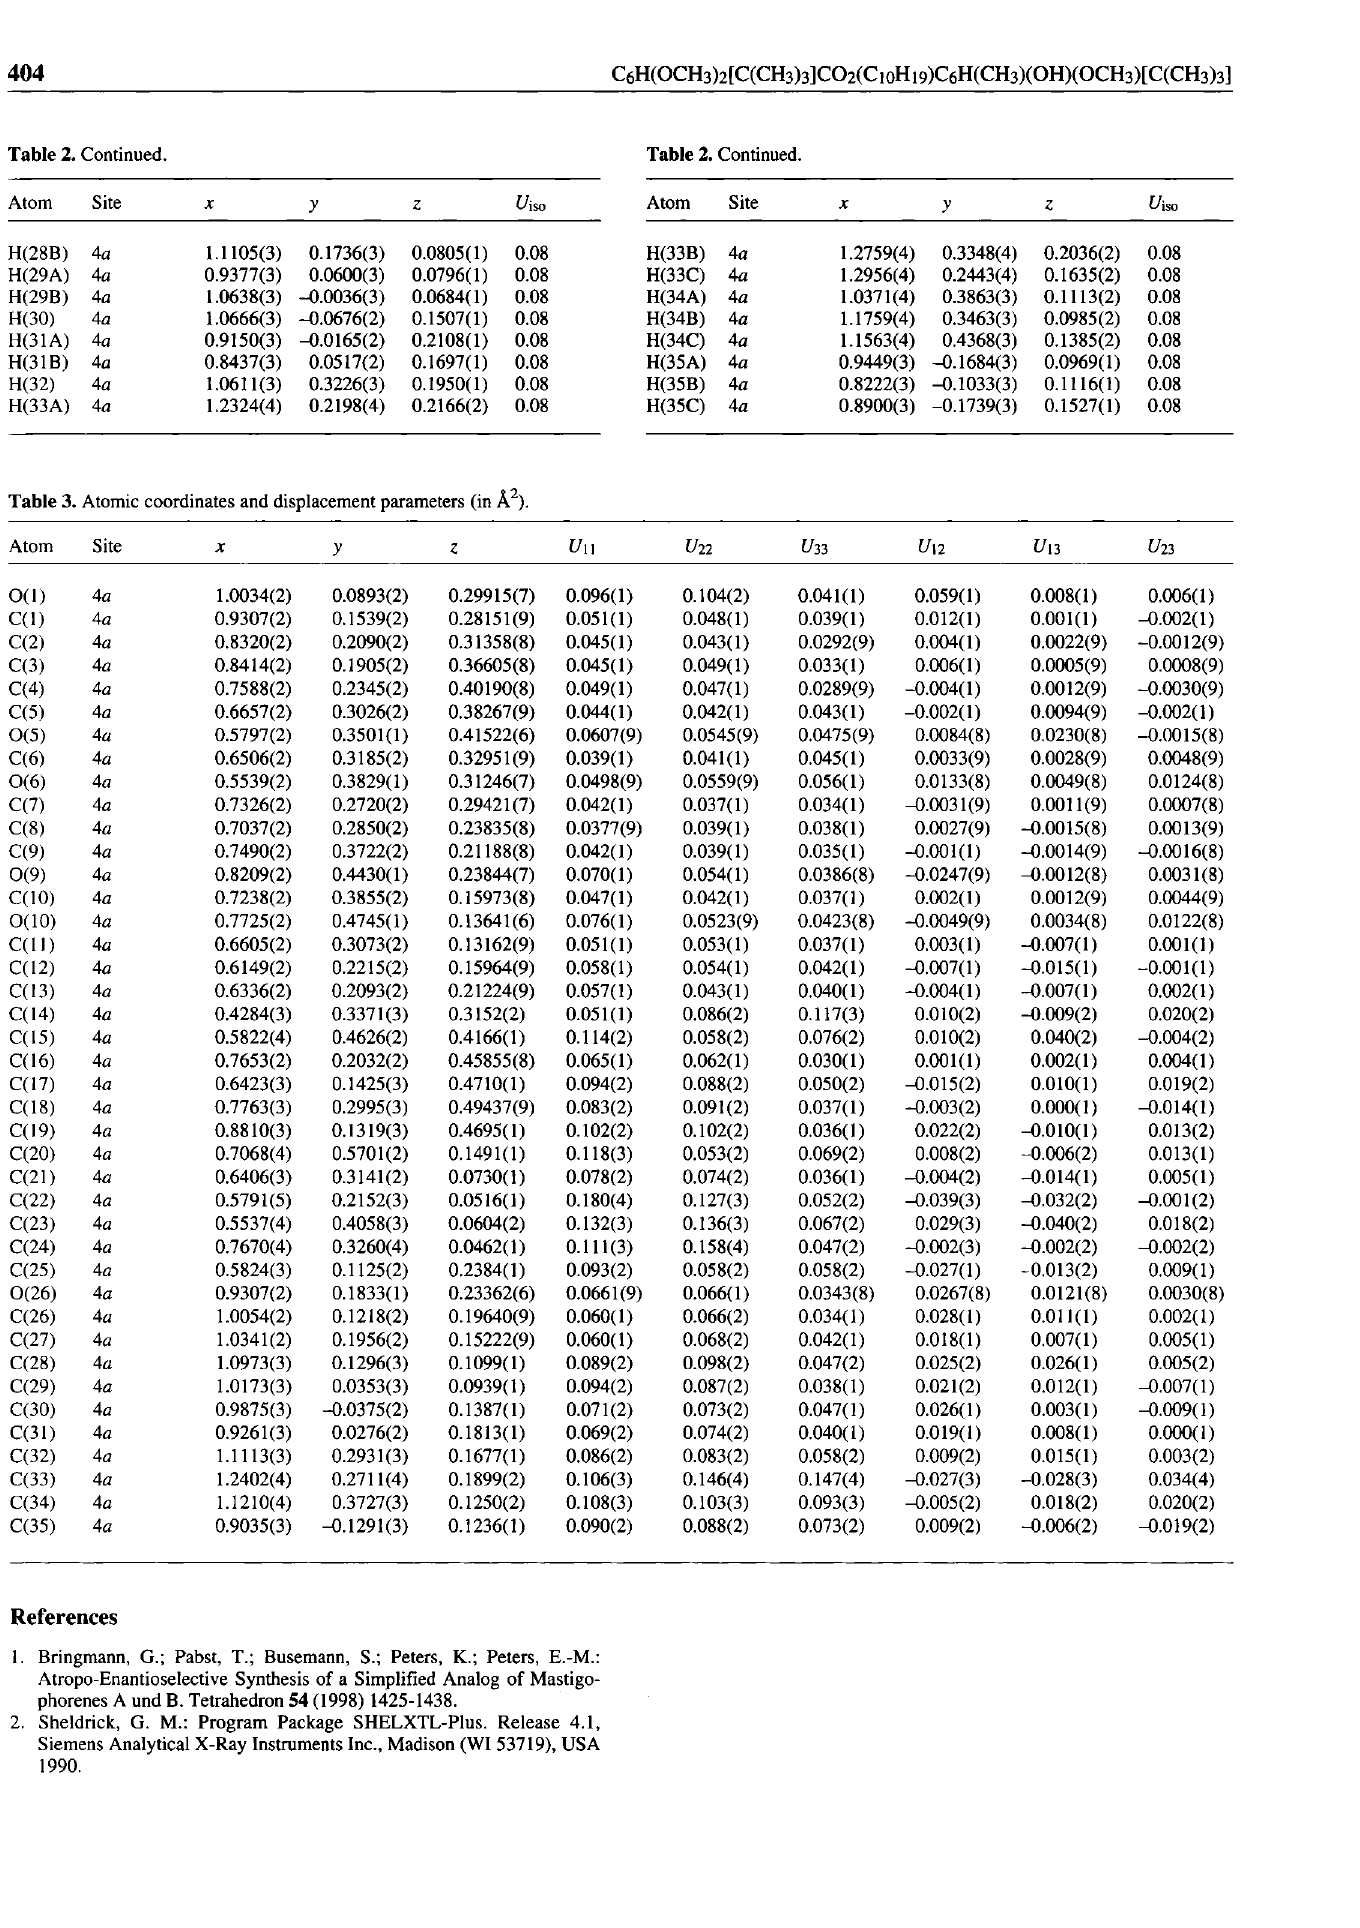
Table 3. Atomic coordinates and displacement parameters (in Ä 2